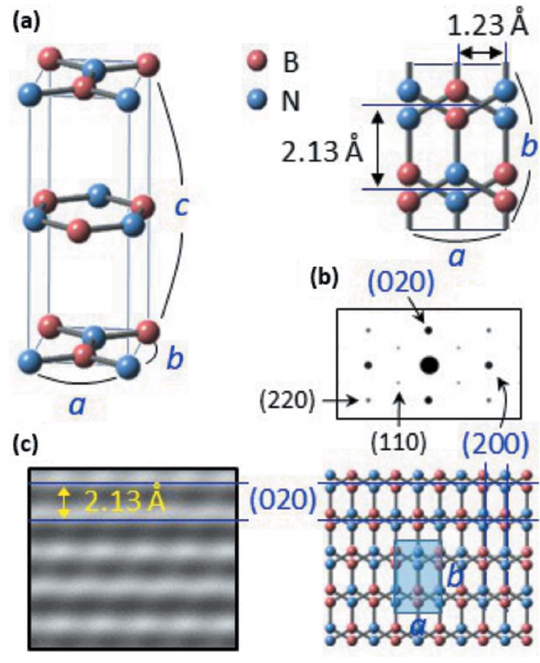
Figure 1 The crystal structure of AA h BN. ( a ) A crystal unit of AA h BN assigned as orthorhombic (No. 31, Pm 2 1 ). ( b ) A simulated ED pattern of AA h BN. Strong (020) and (200) spots result in a diagonal pattern, although relatively weak (110) and (220) spots appear. ( c ) A simulated HRTEM image of AA h BN. Linear lattices, corresponding to (020), are